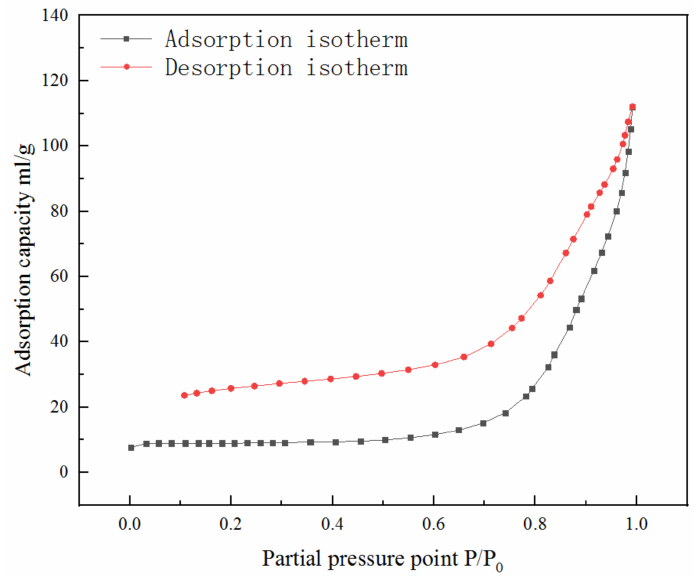
Figure 10. Adsorption-desorption isotherm of the CeO 2 product prepared with A/C =